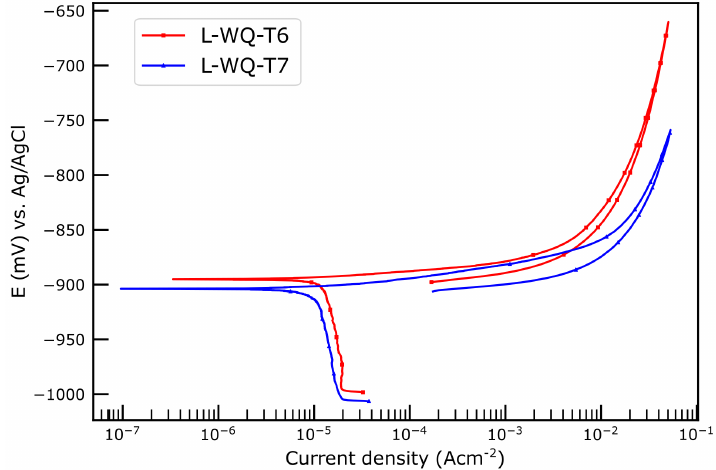
Figure 15. Potentiodynamic polarisation curves of two selected samples that demonstrate clear difference in SCC